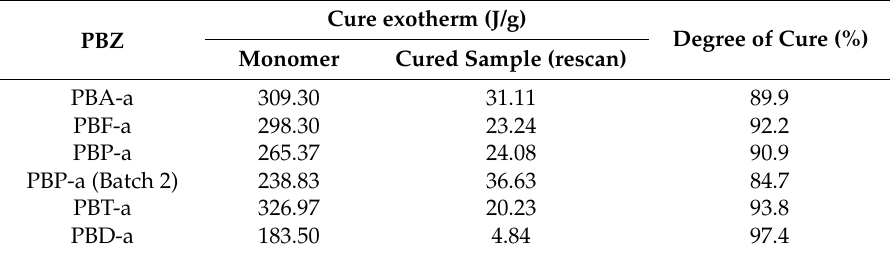
Table 2. Degree of cure of polybenzoxazines.